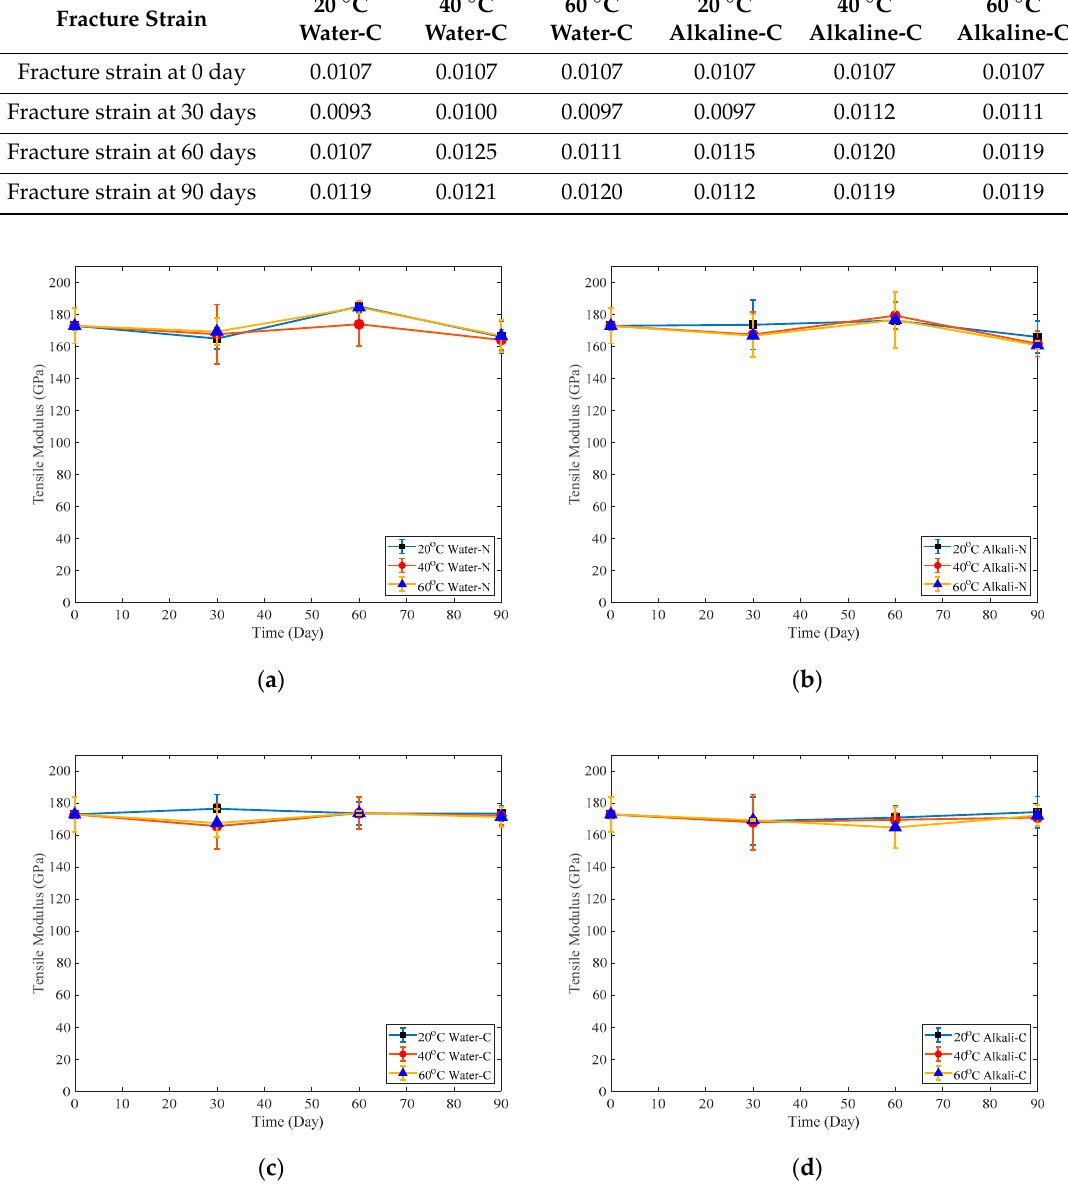
Figure 15. Tensile modulus of: ( a ) Naked plate immersed in water; ( b ) Naked plate immersed in alkaline solution; ( c ) Coated plate immersed in water; ( d ) Coated plate immersed in alkaline solution.